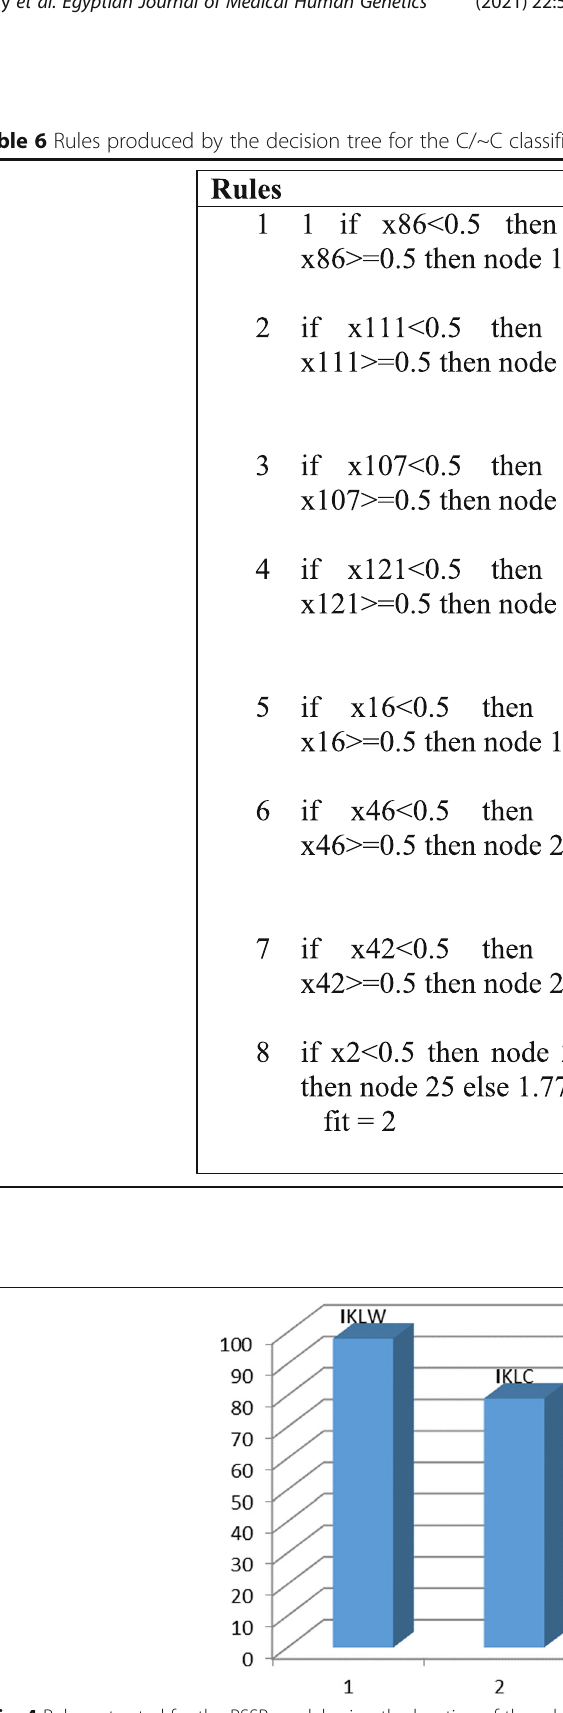
Fig. 4 Rules extracted for the PSSP model using the location of the α